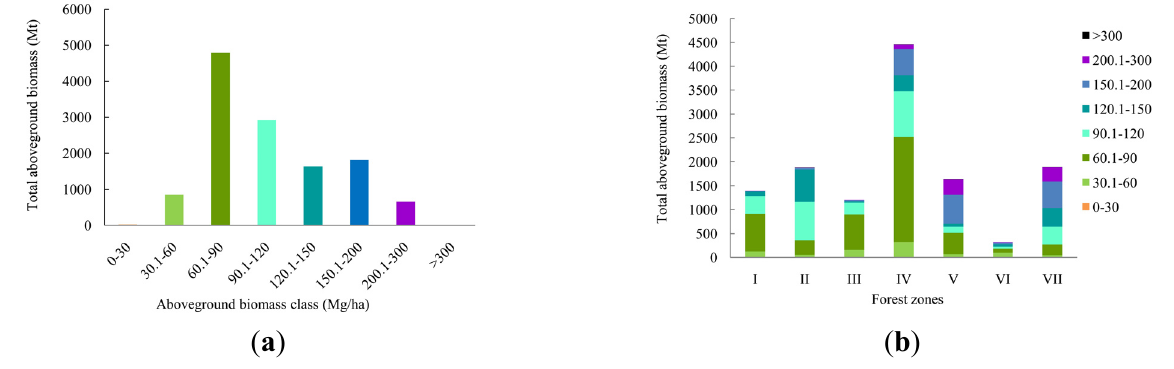
Figure 6. Distribution of forest AGB in seven forest zones in eight